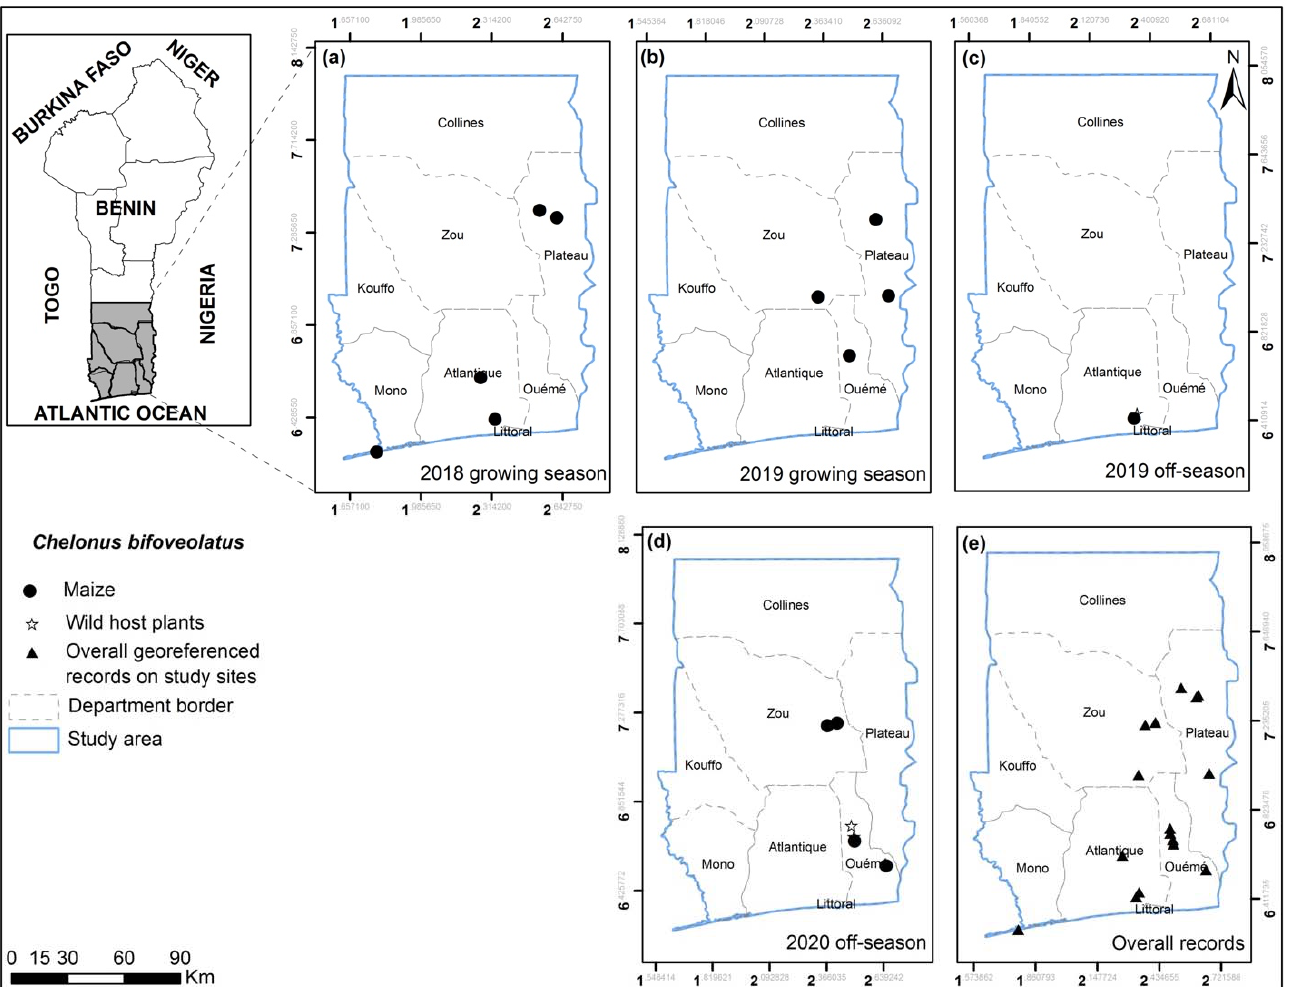
Figure 5. Chelonus bifoveolatus georeferenced records on maize, wild and other cultivated host plants for the years 2018, 2019 and 2020 on the study sites for growing ( a , b ) and off-seasons ( c , d ) in southern and central Benin ( e ). No C. bifoveolatus were found in the 2018 off ‐ season. Table 3. FAW parasitoids recorded on the pest eggs and larvae collected on alternative host plants.